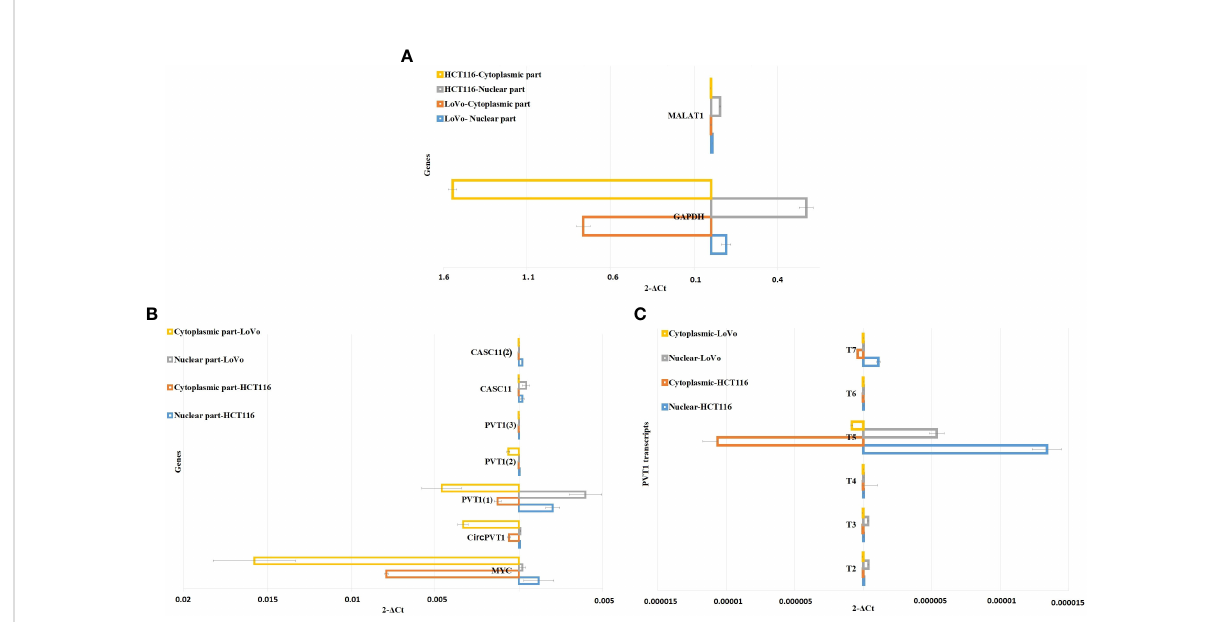
FIGURE 6 Nuclear/cytoplasmic localization of MYC , PVT1 , and CASC11 in LoVo and HCT116. (A) MALAT1 and GAPDH were used as nuclear/cytoplasmic controls, respectively. (B) Nuclear/cytoplasmic localization of MYC , PVT1 , and CASC11 and (C) PVT1 alternative transcripts in LoVo and HCT116 cells.